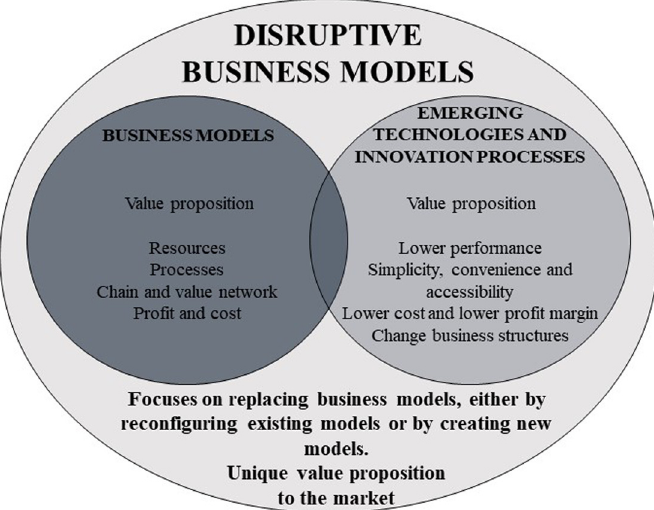
Figure 1. Disruptive business model